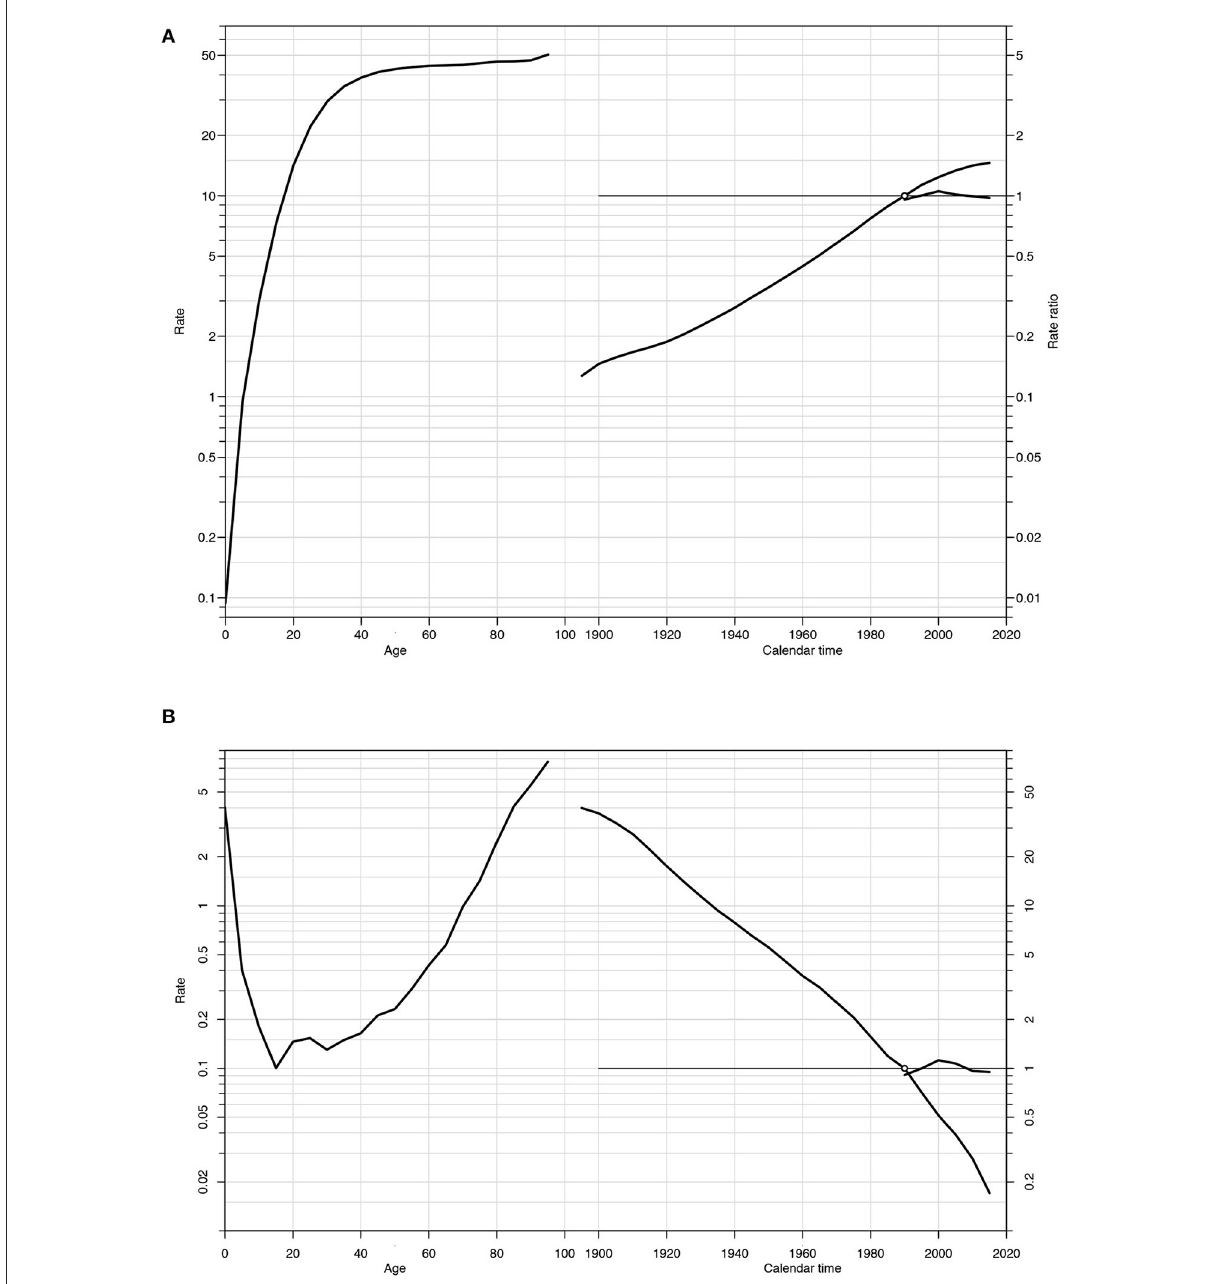
FIGURE7 Estimated age-period-cohort effects for incidence (A) and mortality (B) of IBD in China (1990–2019). Note: Each graph has three curves depicting, from left to right, trends in the incidence or mortality rate by age for the reference cohort (age effect), incidence or mortality risk by birth cohort (cohort effect, taking 1990–1995 as the reference) and incidence or mortality risk by calendar year (period effect, taking the incidence or mortality average of the period as the reference). The graph has the horizontal axis divided into two parts: one for age (years) and one for the cohort period (calendar years). The left vertical axis represents incidence rates (A) or mortality rates (B) for the age effect. The right vertical axis represents the relative risk for the cohort and period effect. The drift is added to the non-linear birth cohort effects and the right plot presents the period effect as residual ratio